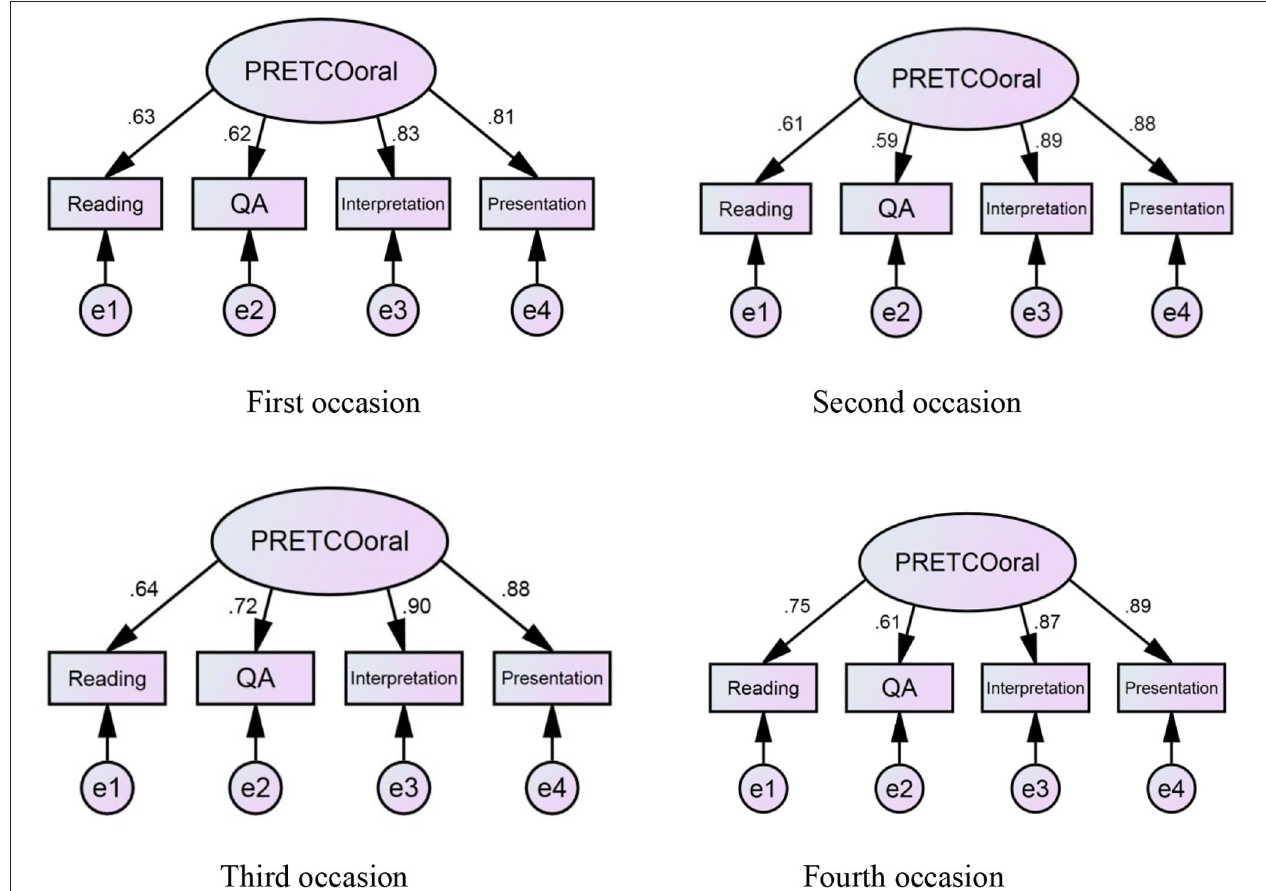
FIGURE 4 | Four occasions of model 1 of PRETCO-oral.